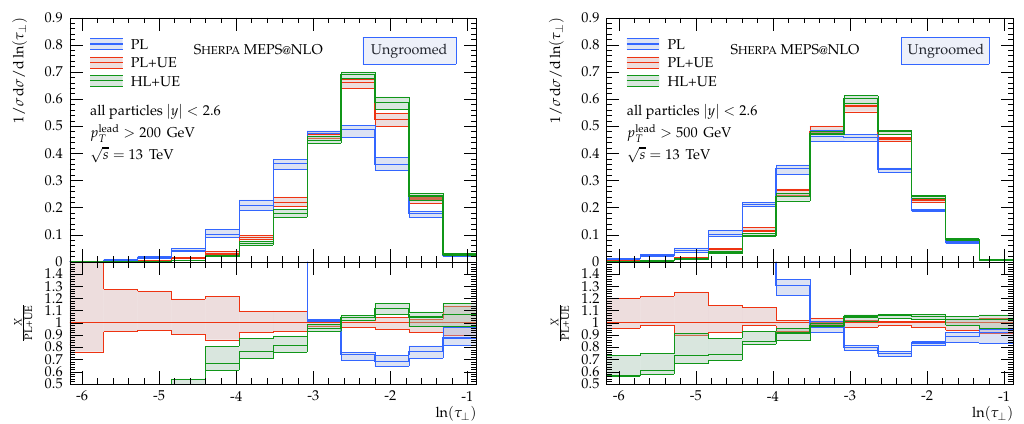
Figure 1 . The transverse-thrust distributions for events with a leading-jet transverse momentum p lead > 200 GeV (left) and p lead > 500 GeV (right). Further details on the event-selection cuts are T T given in section 2.2. Shown are MEPS @ NLO predictions obtained with S HERPA at parton level (PL), with the underlying event included (PL+UE), and at full hadron level (HL+UE). The lower panels show the ratios with respect to the PL+UE